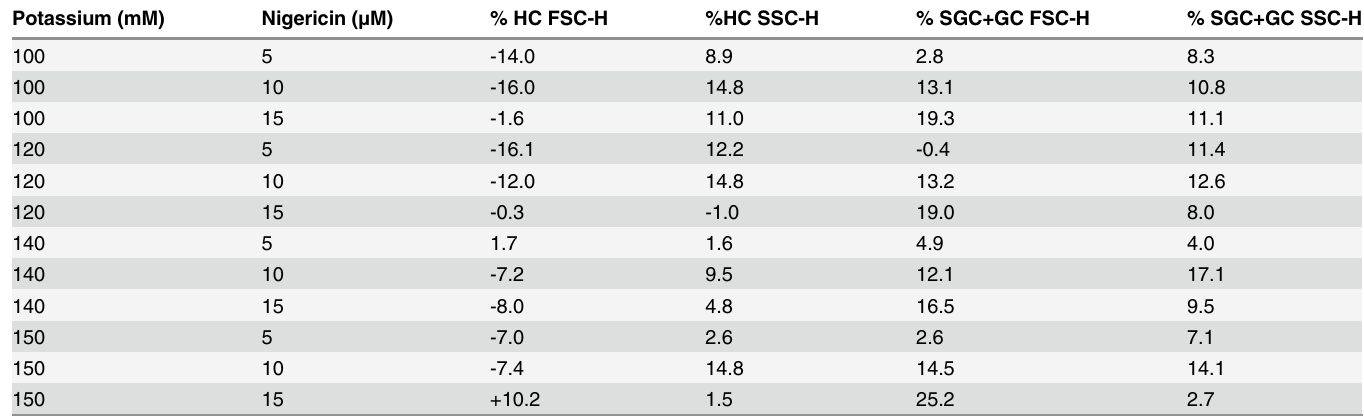
starting with K+ buffers that range from 100 mM to 150 mM K + , which is usually the range of K + in the cytosol. There is little known to date of the K + in crustacean hemocytes; therefore, an experiment testing different K + levels (100 to 150 mM in 10 mM intervals) and different nigeri- The concentrations of K + and nigericin listed above are the final concentrations in the staining tube with all added reagents and hemolymph. Two methods were applied to determine if the hemocytes were affected by the K + and nigericin solution (1) flow cytometry analysis and (2) visual confirmation under the microscope. Ruptured hemocyte cells in the K + buffer with nigericin and the SNARF produced different forward and side scatter plots (FSC-H and SSC-H, respectively) compared to hemocyte cells in seawater. Before analysis with the K + buffer, the mean FSC-H and SSC-H for both SCG+GC and HC cells were determined for 5 Tanner crabs. The variability in FSC-H and SSC-H between these individuals averaged 6.1 ±1.0% for HC and SGC+GC cells. Table 2 shows mean FSC-H and SSC-H at each K + buffer and nigericin combination relative to an untreated Tanner crab hemocytes. The test tube that had a final stock solution of 140 mM of K + buffer and 5 μ M nigericin had the lowest % change relative to the control sample ( < 5%). Therefore, after analyzing the matrix of different K + and different nigericin levels, the following K + stock solution was employed: 280 mM potassium